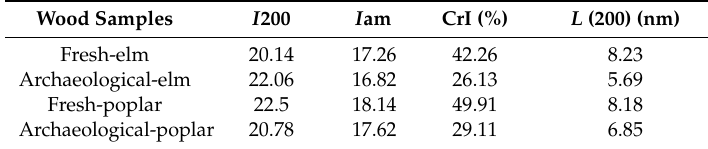
Figure 3. X-ray diffractograms from archaeological wood (AW) and fresh wood (FW) of elm ( a ) and Figure 3. X-ray di ff ractograms from archaeological wood (AW) and fresh wood (FW) of elm ( a ) and poplar ( b ). poplar ( b ). Table 2. Band positions of crystalline and amorphous cellulose and the calculated parameters for the wood